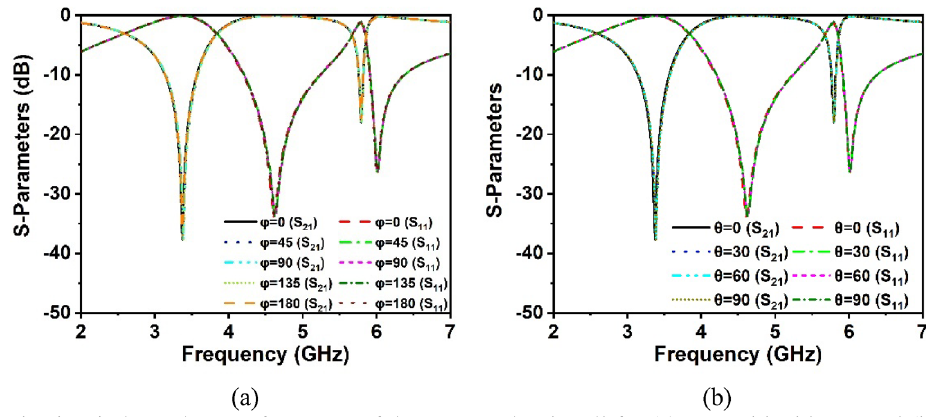
Figure 9. Polarization-independent performance of the proposed unit cell for ( a ) normal incidence and ( b ) oblique incidence.